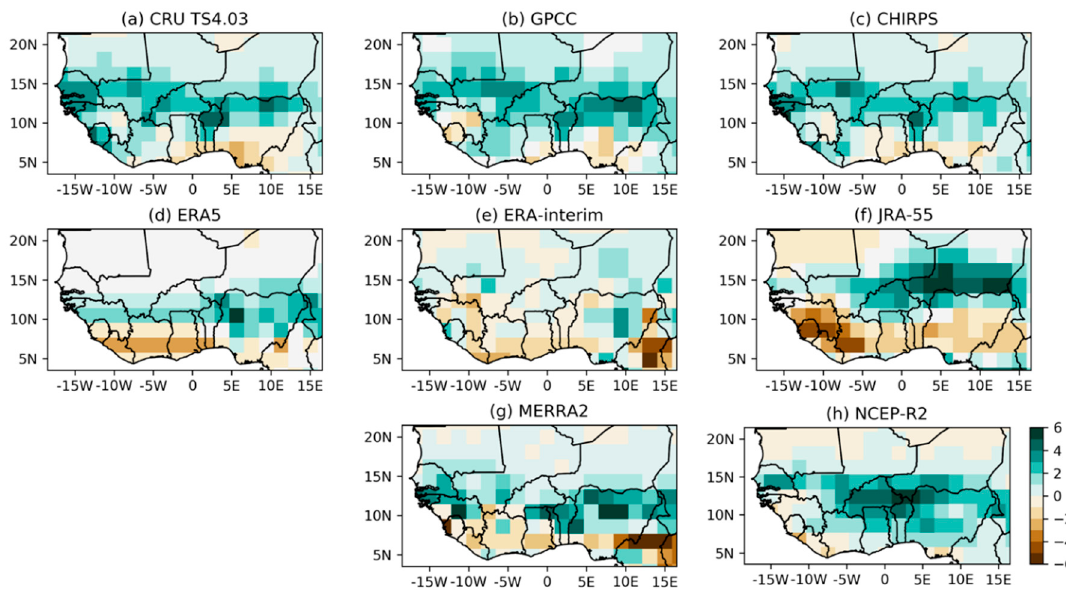
Figure 10. Spatial patterns of mean precipitation (mm day − 1 ) for the month of August averaged for the difference in wet and dry consensus years within the period 1981–2016.